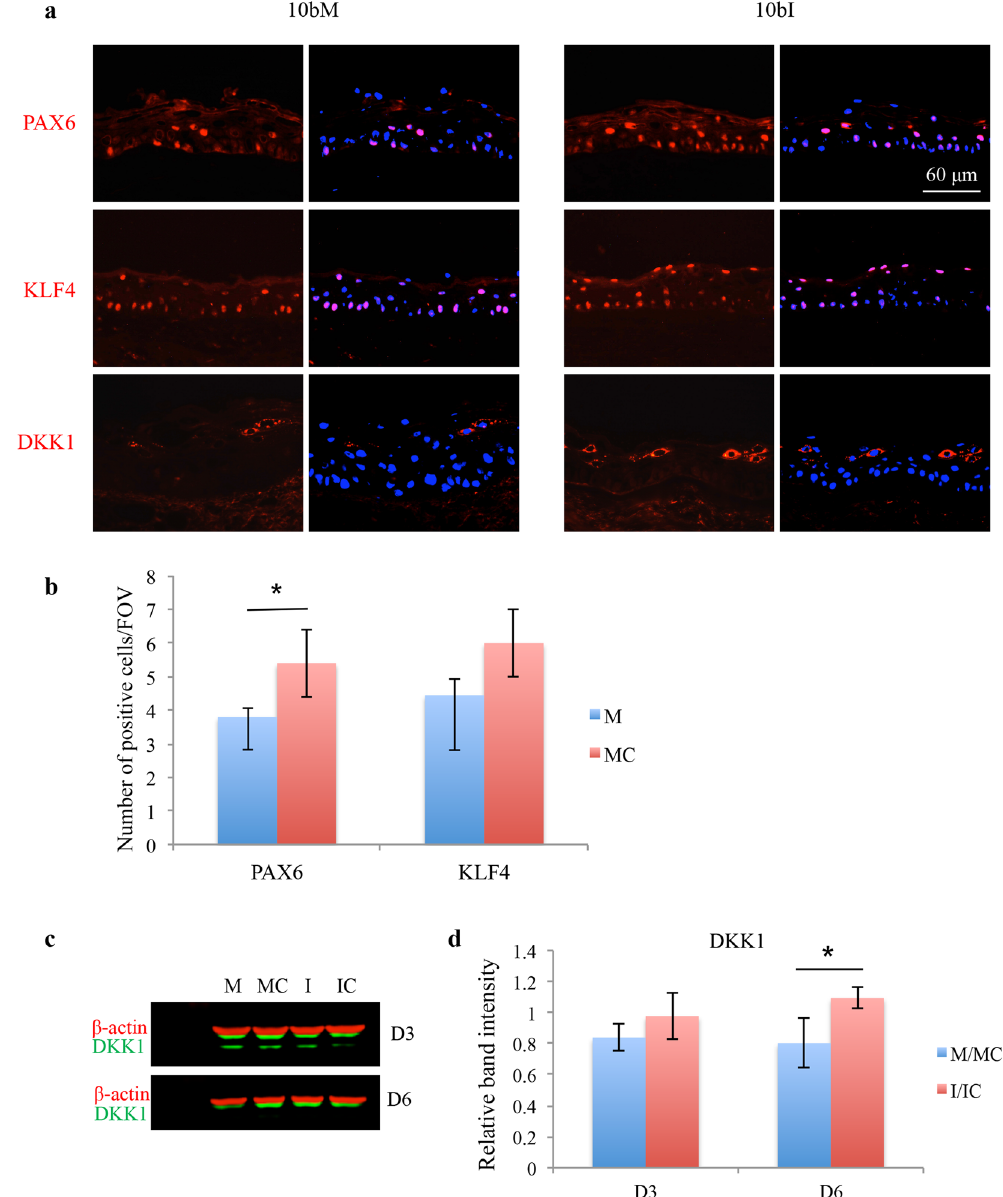
Figure 8. Effect of miR-10b on its predicted targets in human organ-cultured corneas and in HCEC. ( a ) Transfection with miR-10b (10bM) showed decreased, whereas with miR-10b inhibitor (10bI) increased staining for PAX6, KLF4 and DKK1 in human organ-cultured corneas (n = 4). The same exposure time was used for each set of compared immunostained sections, the pictures are representative of two to three independent experiments of each transfected organ-cultured corneas (n = 4). ( b ) The staining assessment was done by more than one observer. The bar graph represents average ± SEM of pooled values (n = 4) in duplicates or triplicates. ( c ) Western blot analysis of total extracted protein from transfected HCEC with miR-10b mimic (M) or its inhibitor (I) and their corresponding controls, mimic control (MC) and inhibitor control (IC), respectively, after day 3 (D3) or day 6 (D6), and ( d ) Quantitation of DKK1 protein level in western blot. The bar graph represents average ± SEM of pooled values (n = 4) of densitometric scans. * P < 0.05, compared with scrambled control values by paired two-tailed t